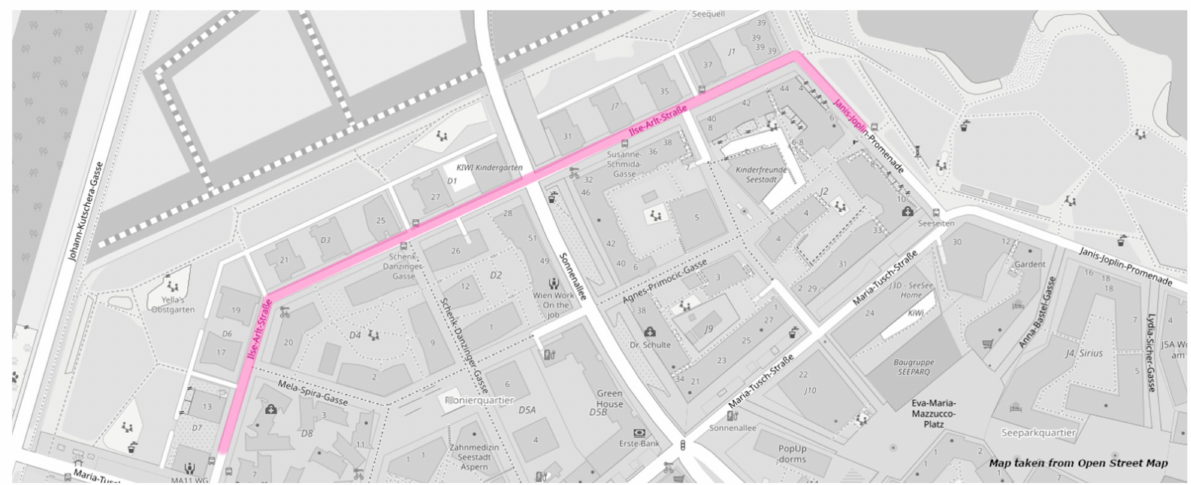
Figure 3. Test track along the pilot site of the autonomous shuttles in